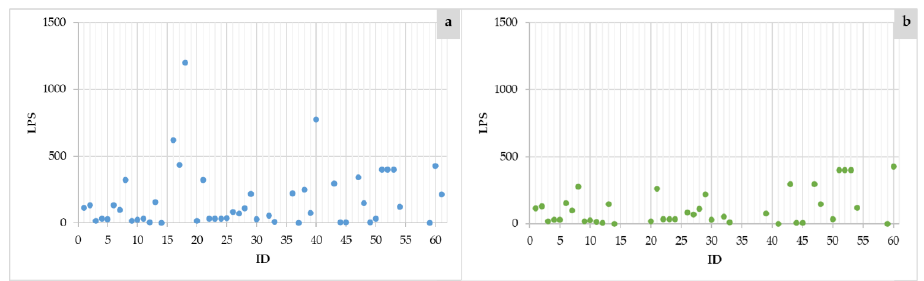
Figure 5. Average Flow (L/s) for OS ( a ) and MS ( b ).